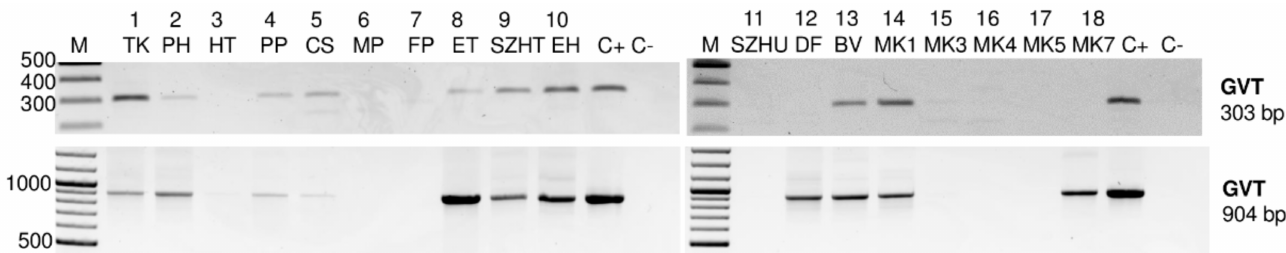
Figure 1. Validation of sRNA HTS by RT-PCR of the vineyard pools for the presence of GVT. Amplification was done using two different sets of primers, amplifying the 303 or 904 bp region of the coat protein coding region. Sample numbers, together with the vineyard codes, were used. M-GeneRuler 100 bp Plus, C-/C+ negative, and positive controls using water or cDNA prepared from a virus infected